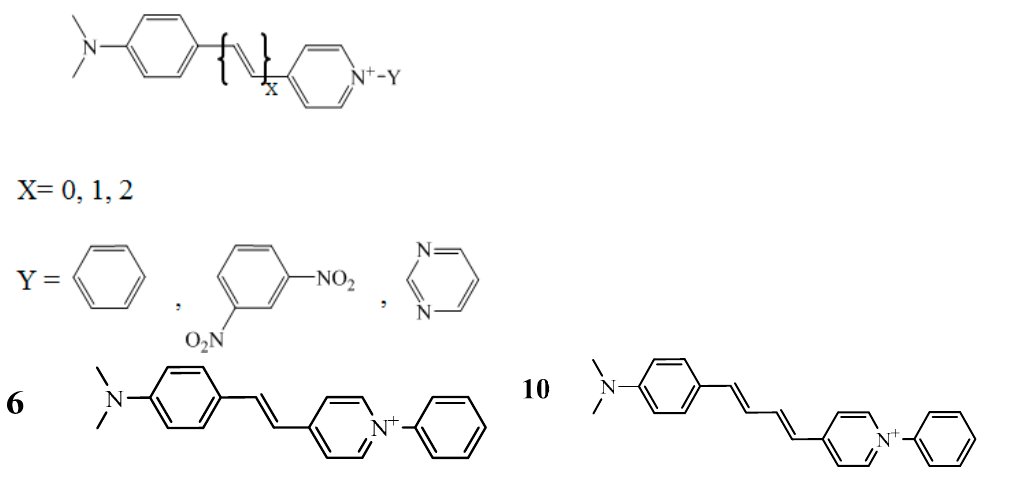
Figure 21. Molecular structures with modified Part E.